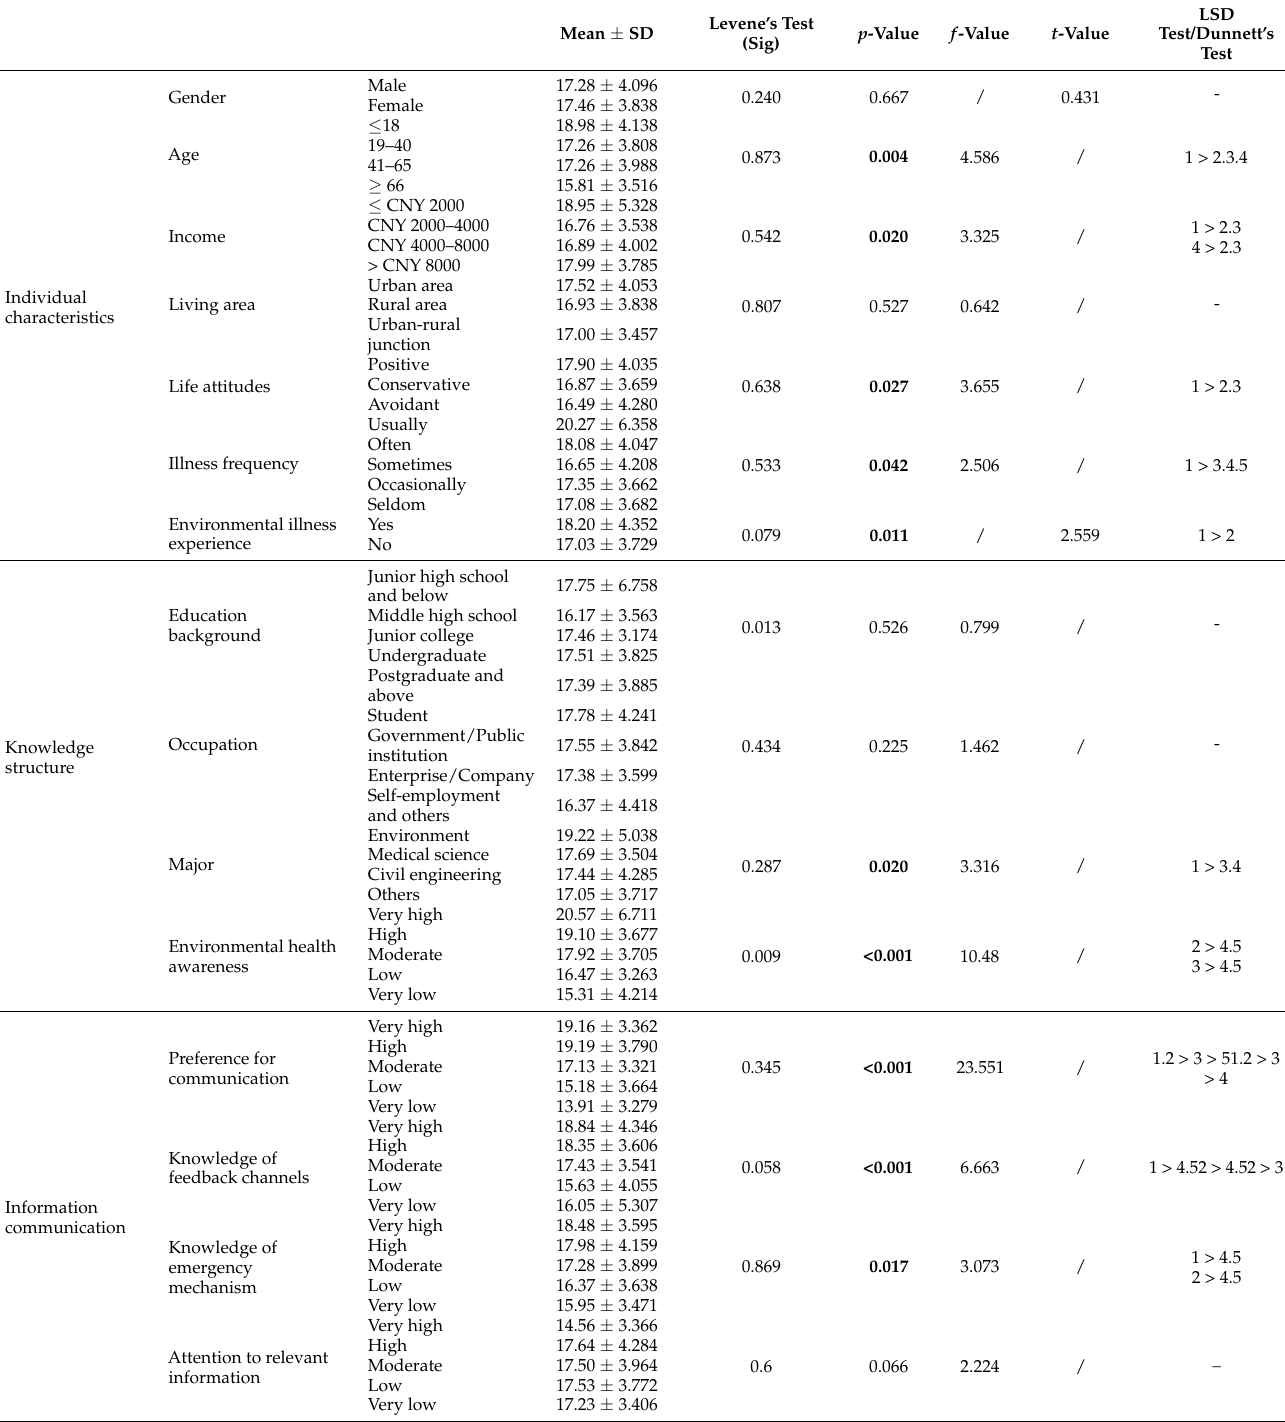
Table 6. Results of the adaptability